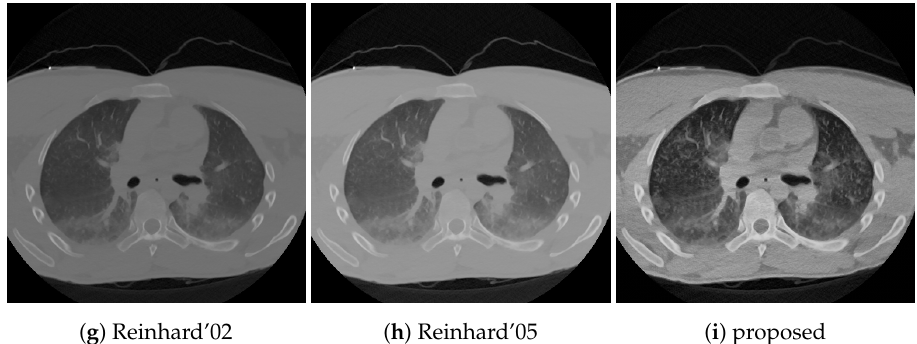
Figure 5. Tone mapped chest CT scan with eight common operators and the proposed method. Parameters are summarized in Table 1; a quantitative comparison is presented in Table 2.